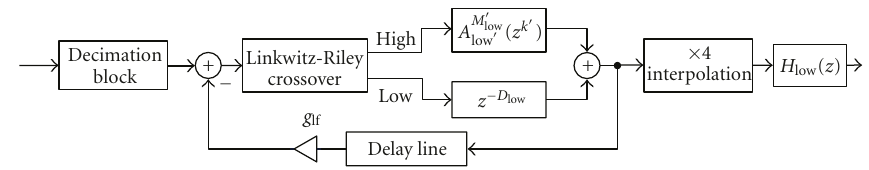
Figure 7: Block diagram showing C lf with